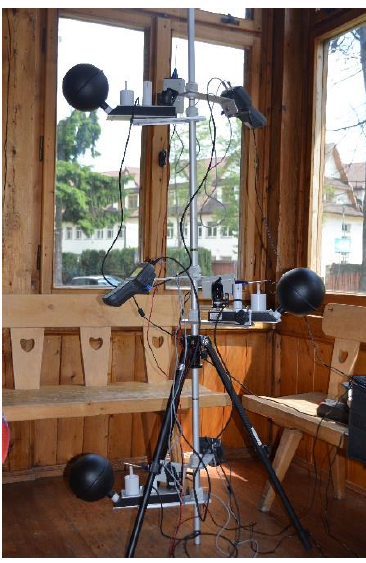
Figure 7. Test device for measuring thermal comfort [30].